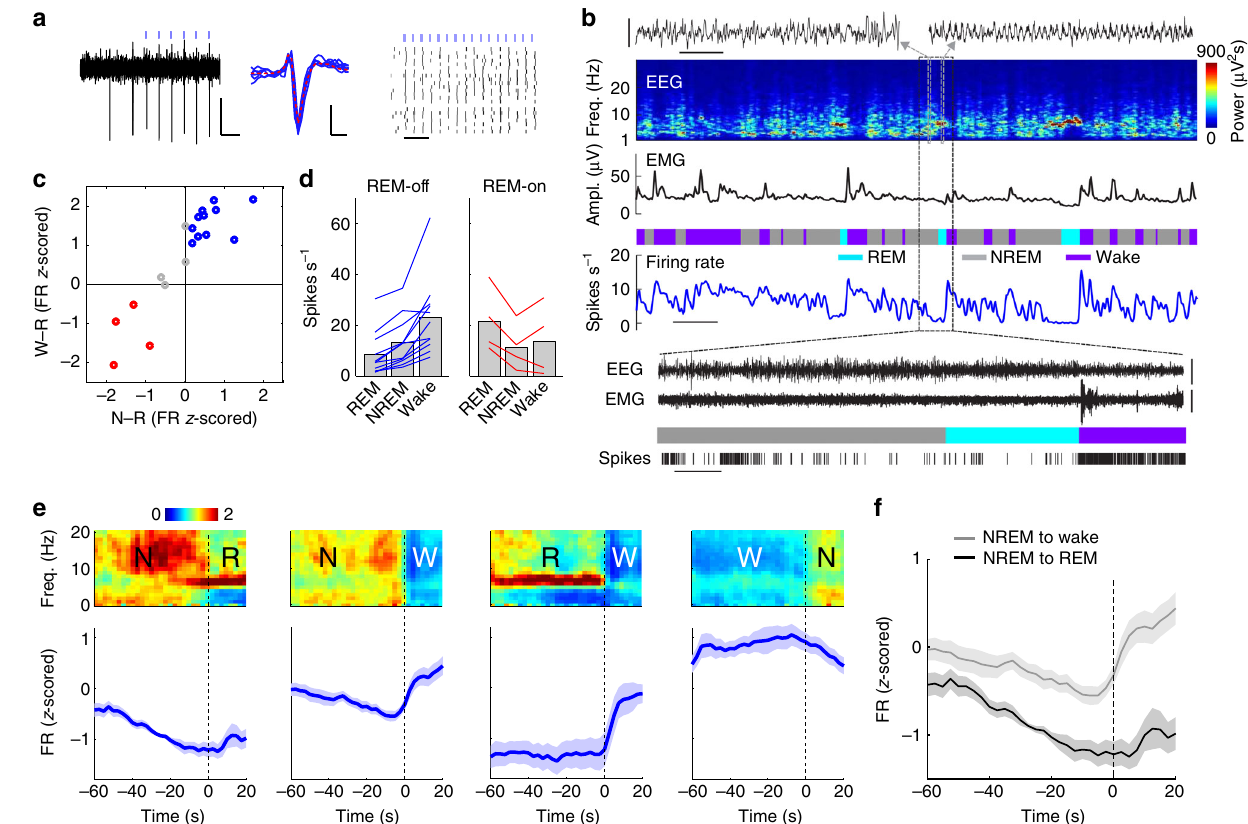
Fig. 3 Firing rates of identi fi ed vlPAG GABAergic neurons across brain states. a Example unit. Left, raw trace showing spontaneous and laser-evoked spikes. Blue ticks, laser pulses (15 Hz). Scale bars, 100 ms, 0.5 mV. Middle, comparison between laser-evoked (blue) and averaged spontaneous (red) spike waveforms from this unit. Scale bars, 0.2 ms, 0.5 mV. Right, Spike raster showing multiple trials of laser stimulation at 30 Hz. Scale bar, 100 ms. b Firing rates of an example vlPAG GABAergic neuron (blue) along with EEG spectrogram, EMG amplitude, and color-coded brain state (scale bar, 120 s). Two example EEG raw traces (indicated by gray boxes) are shown on top of the EEG spectrogram (scale bars, 1 s, 0.5 mV). The timing of single spikes (vertical ticks) is depicted on an expanded timescale (indicated by black box) along with EEG, EMG raw traces (scale bars, 10 s, 0.5 mV). c Firing rate modulation of 19 identi fi ed units from 6 mice. W wake, R REM, N NREM. Blue, signi fi cant REM-off neurons (P < 0.05, Wilcoxon rank-sum test, post-hoc Bonferroni correction); red, signi fi cant REM-on neurons; gray, other neurons. d Firing rates of signi fi cant REM-off (left) and REM-on (red) neurons during different brain states. Each line shows fi ring rates of one unit; gray bar, average across units. e Average EEG spectrogram (upper, normalized by the mean power in each frequency band) and mean fi ring rate ( z -scored) of signi fi cant REM-off neurons (lower) at brain state transitions. Shading, ± s.e.m. f Firing rates during NREM episodes preceding wake were signi fi cantly higher than those preceding REM episodes ( P = 0.0001, T (8) = − 7.03, paired t